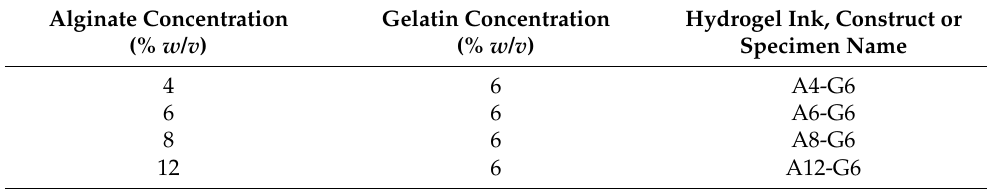
Table 1. Formulations and respective nomenclature for the inks and the corresponding bioprinted constructs. Alginate Concentration (% w / v